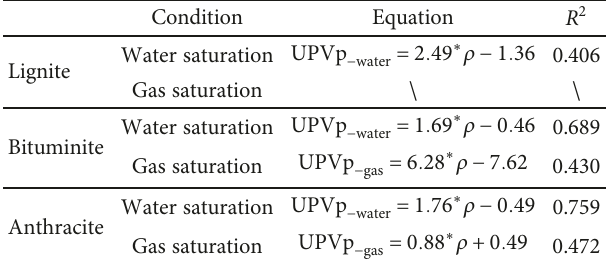
Table 5: Correlations between UPVp and porosity under water and gas saturation. Condition Equation R